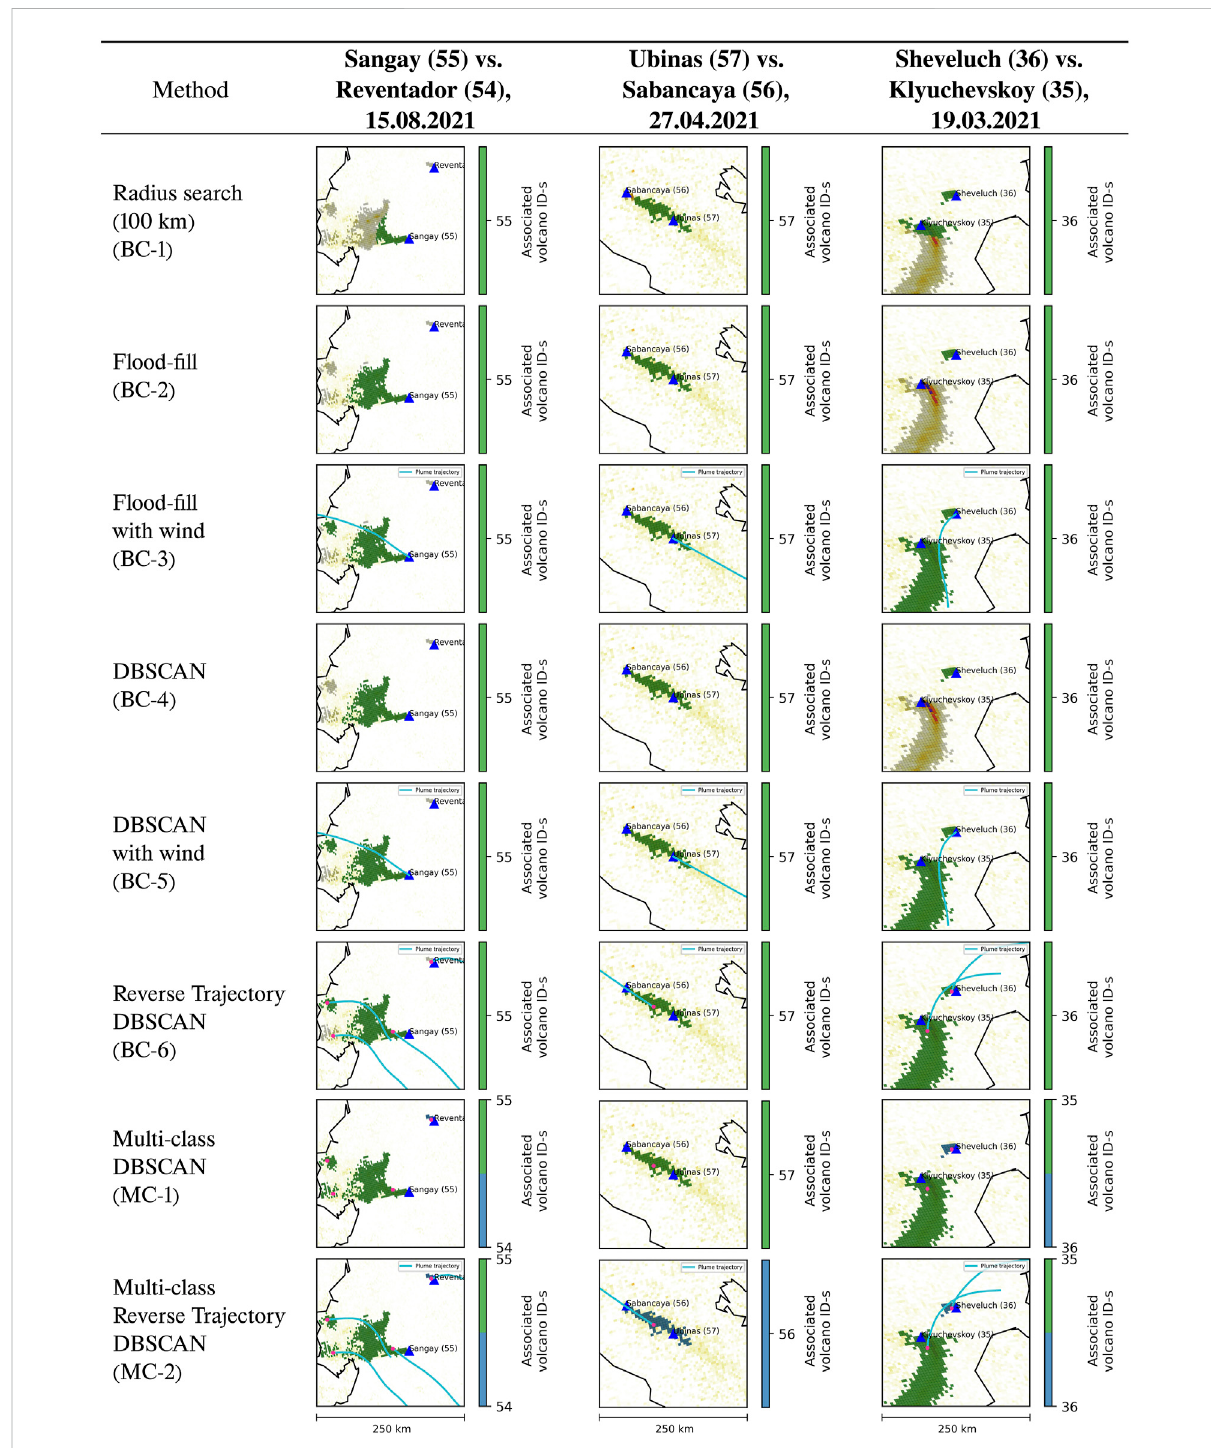
FIGURE 6 Plotsofevaluationrunswithdifferentclassi fi eralgorithmsonthreevolcanicscenarios.Theplotsrepresent250×250 kmregions.Magentadots represent cluster center of mass, and cyan lines are computed plume